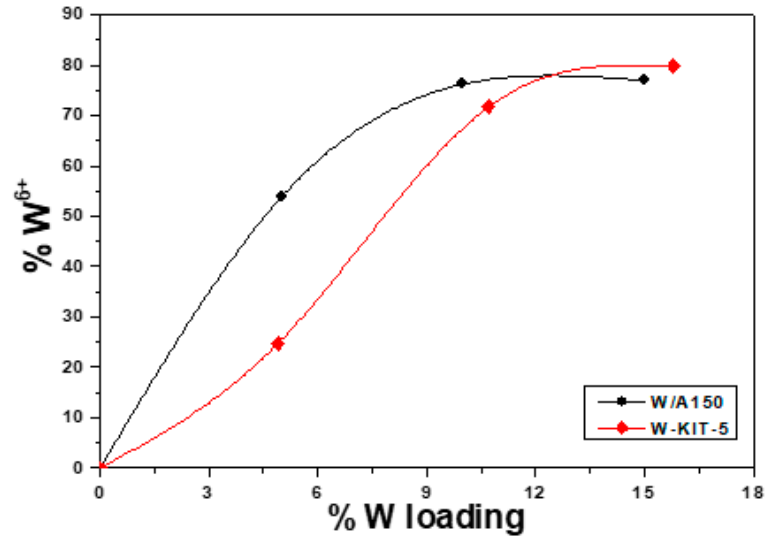
Figure 3. The % relative amount of W 6+ oxidation state detected in each catalyst, as a function of the % W loading. Table 1. Chemical characteristics, textural properties, and acidity of the synthesized